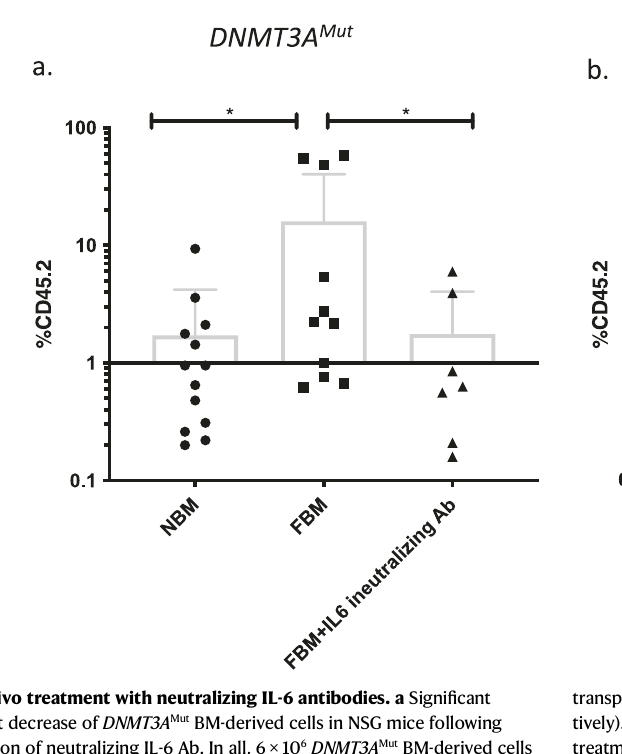
Fig. 5 | Selective advantage to DNMT3A Mut BM-derived cells under methylcel- lulose colony assay. a Number of colonies in methylcellulose (MethoCult M3334) colony-forming-unit assays of DNMT3A Mut and DNMT3A WT BM-derived cells. Data was analyzed by two-way ANOVA test — Sidaks multiple comparison test. Data are presented as mean values±s.d. n =3 biologically independent experiments. **** P <0.00001. b Representative photograph of the methylcellulose plating from ( a ). Scale bar: 100 μ M. c – f All comparisons were performed using a two-tailed,